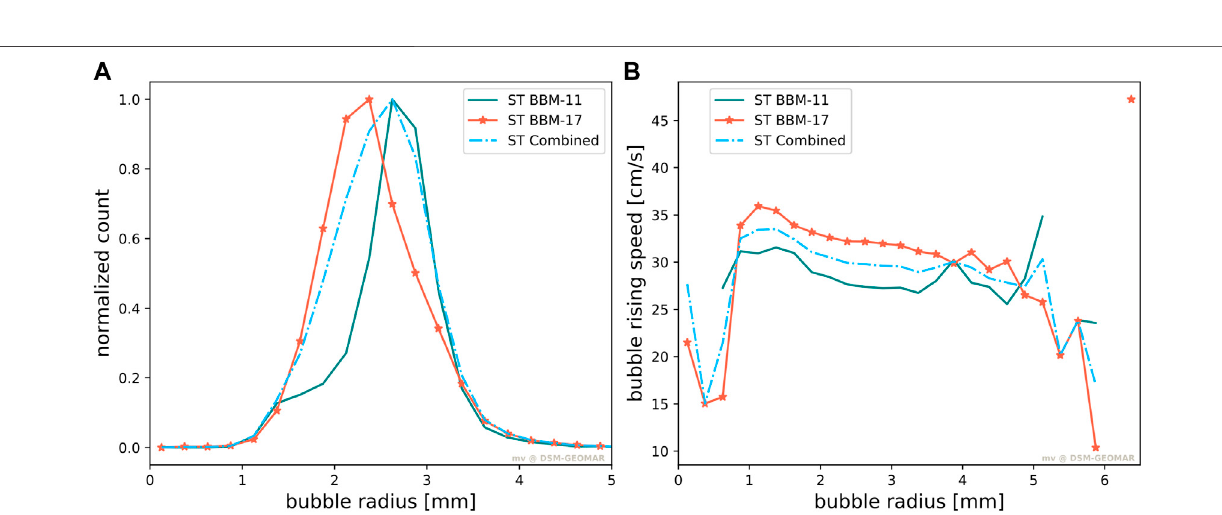
Frontiers in Earth Science |